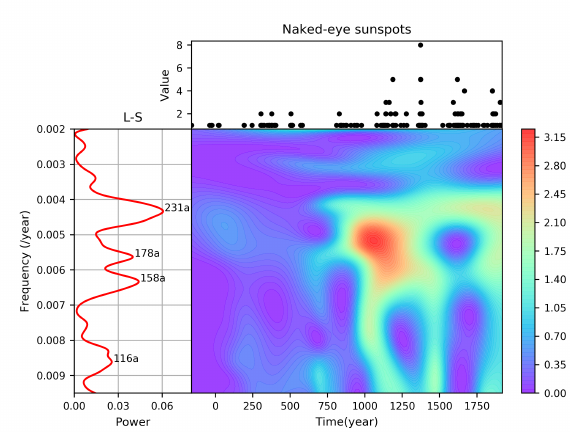
Figure 1. The weighted wavelet Z-transform (WWZ) results and the Lomb-Scargle periodogram of the naked-eye observations of sunspots from 200 BC to 1918 AD.